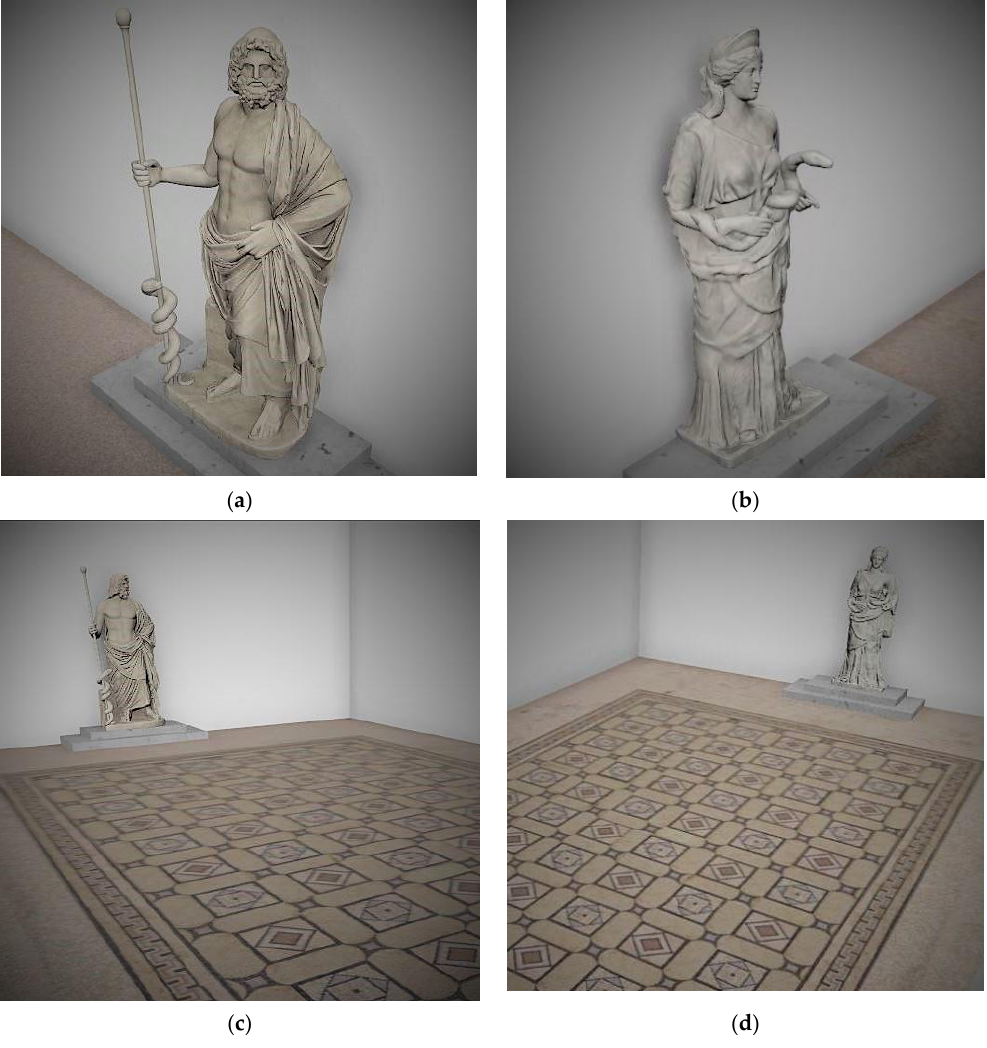
Figure 13. Hypothetical reconstruction of the archaeological context ( cella ) with the placement of the statues on the podium: ( a , b ) hypothetical top-view and ( c , d ) distant view of the statues on the podium inside the mosaic room.